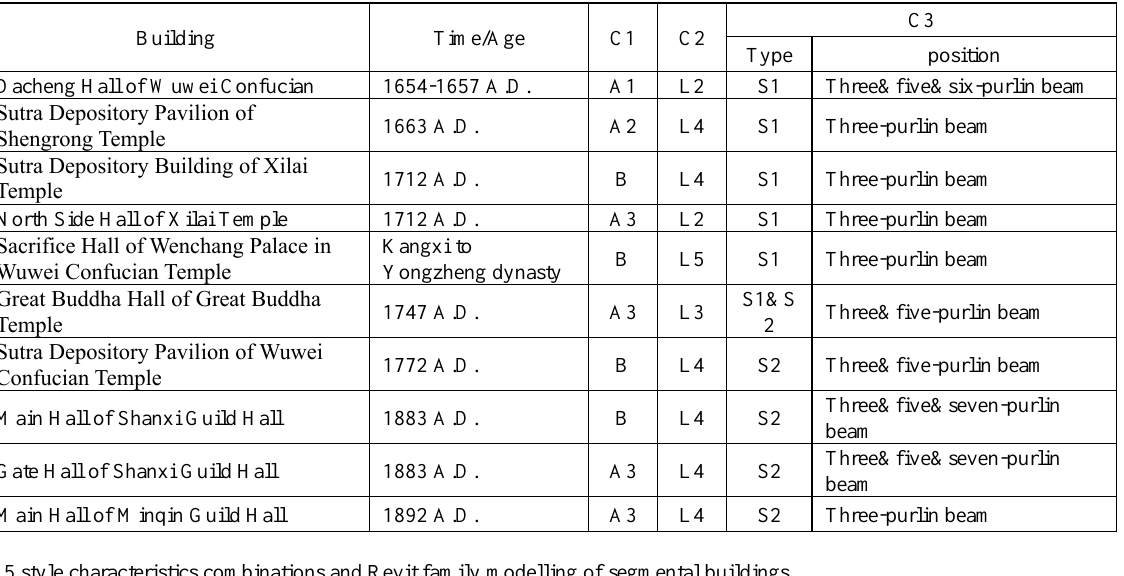
Table.5 style characteristics combinations and Revit family modelling of segmental buildings